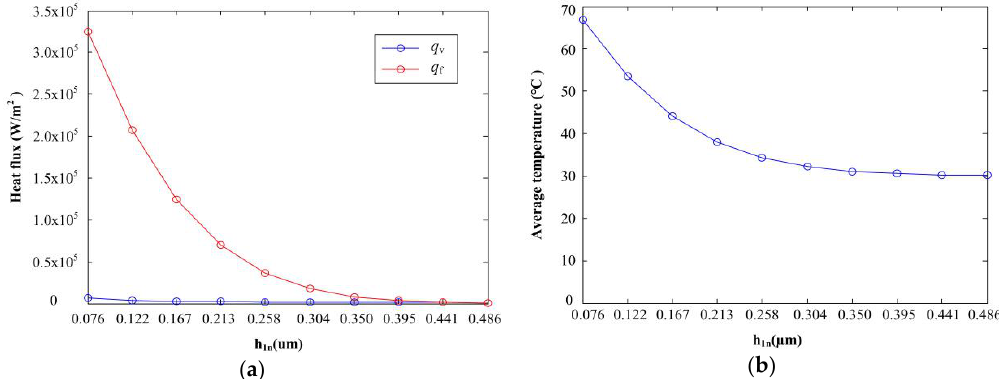
Figure 13. ( a ) Average heat flux for different thicknesses of the tapered film; ( b ) average temperature of the sealing fluid for different thicknesses of the tapered film after shaft deceleration.